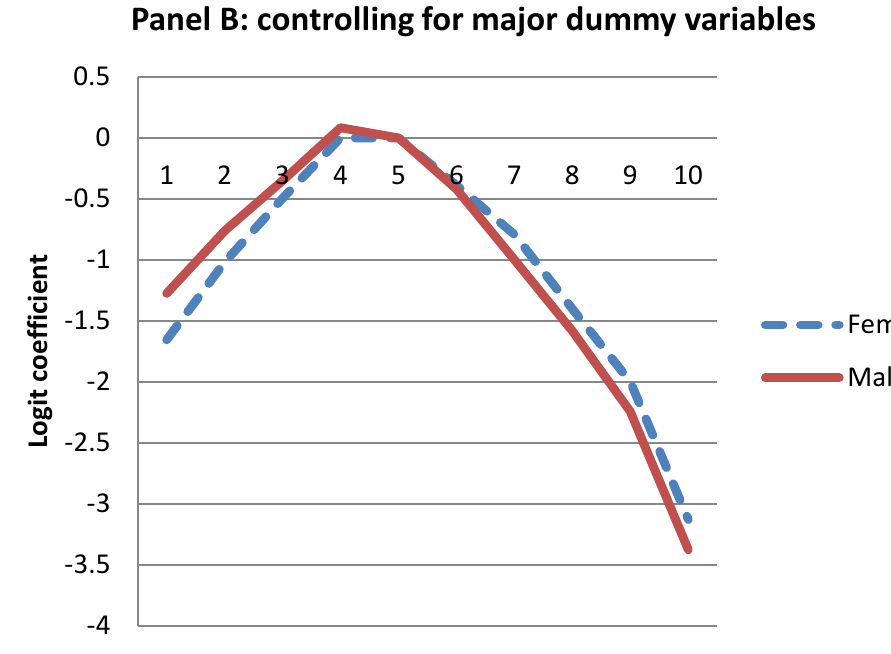
sociological science |